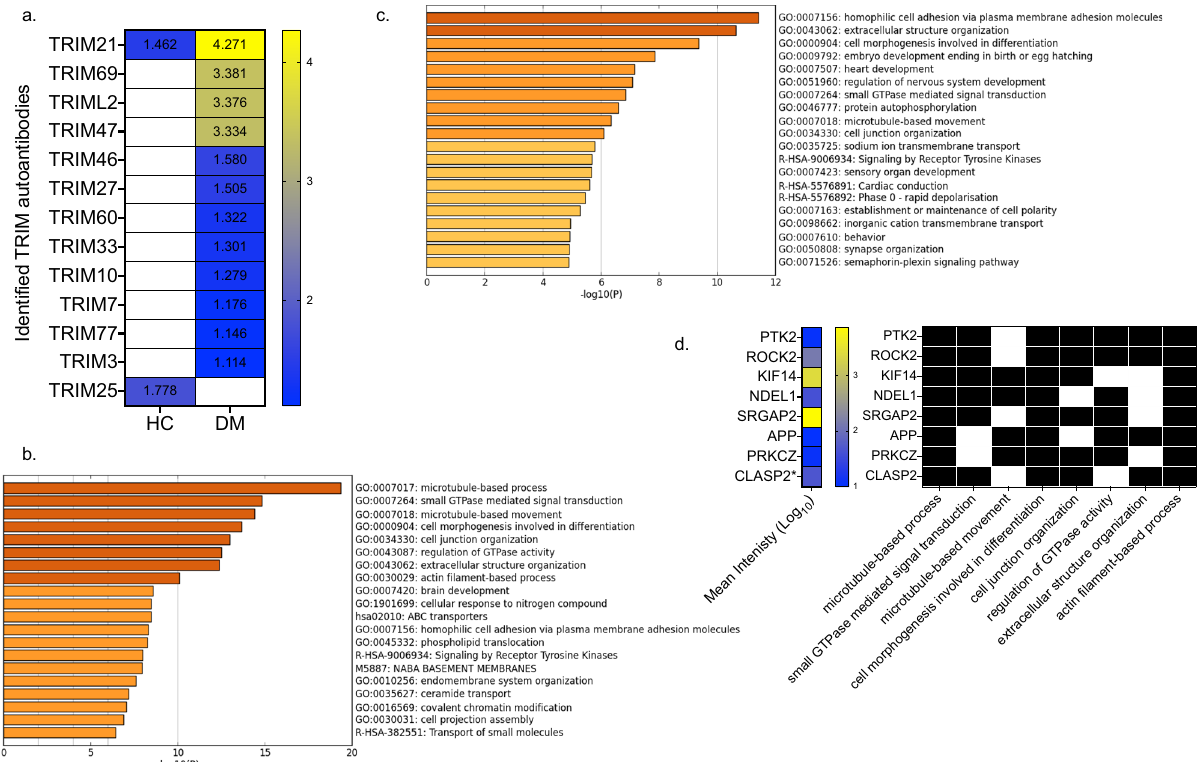
Fig. 5 TRIM autoantibodies identi fi ed in Dermatomyositis. a Heatmap of mean log 10 intensities of identi fi ed TRIM proteins in healthy control (HC) and dermatomyositis (DM). Gene ontology processes signi fi cantly enriched in b DM, and c HC. d Binary colour-coding of presence/absence of the autoantibody protein targets that were enriched in at least six out of eight DM-speci fi c GO processes (presence: black, absence: white). The mean log 10 intensity of each protein is annotated in a colour coded heatmap (low: blue to high: